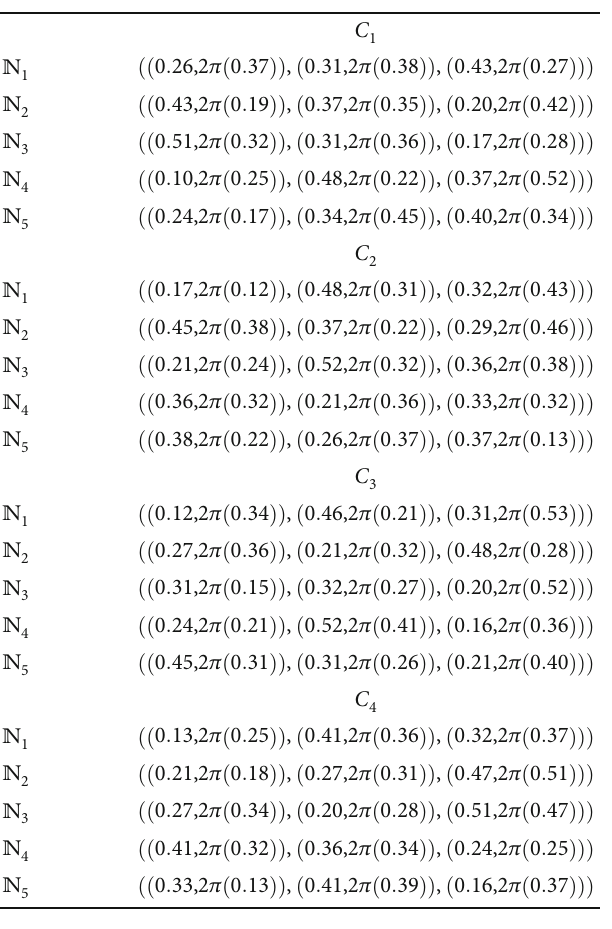
Table 5: Aggregated values using CSFOWPG operator. Table 6: Rating values of the transferred alternative ℕ /